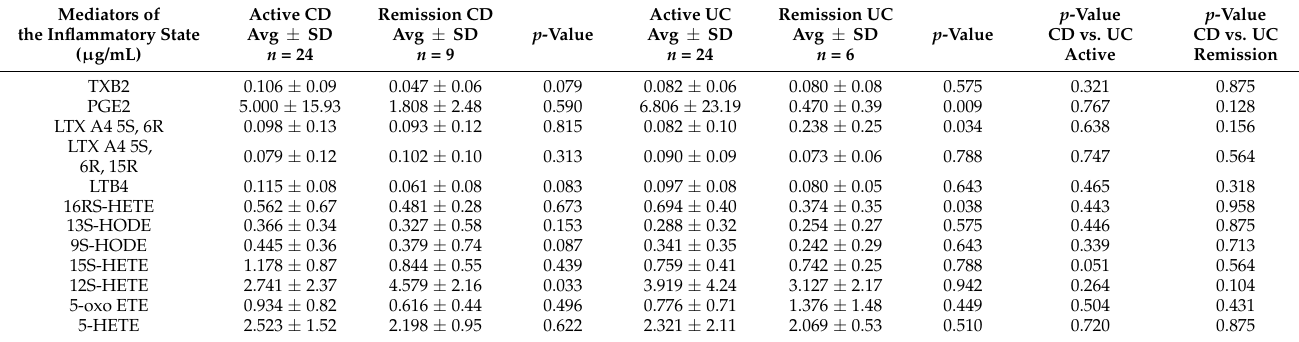
Table 4. Characteristics of selected lipid mediators in CD and UC groups in patients with active disease and